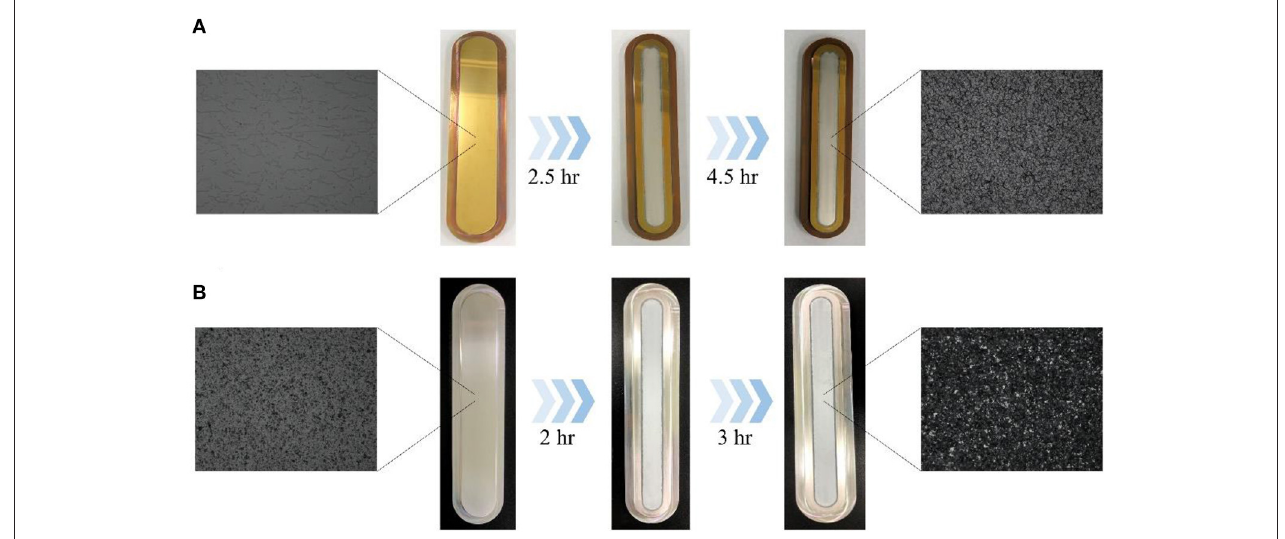
FIGURE 2 | Enriched target electroplated onto substrate (Au-Cu and Ag) (A) 64 Ni electrodeposition with Au-Cu substrate (B) 70 Zn electrodeposition with silver substrate (magnification under optical microscope X20).